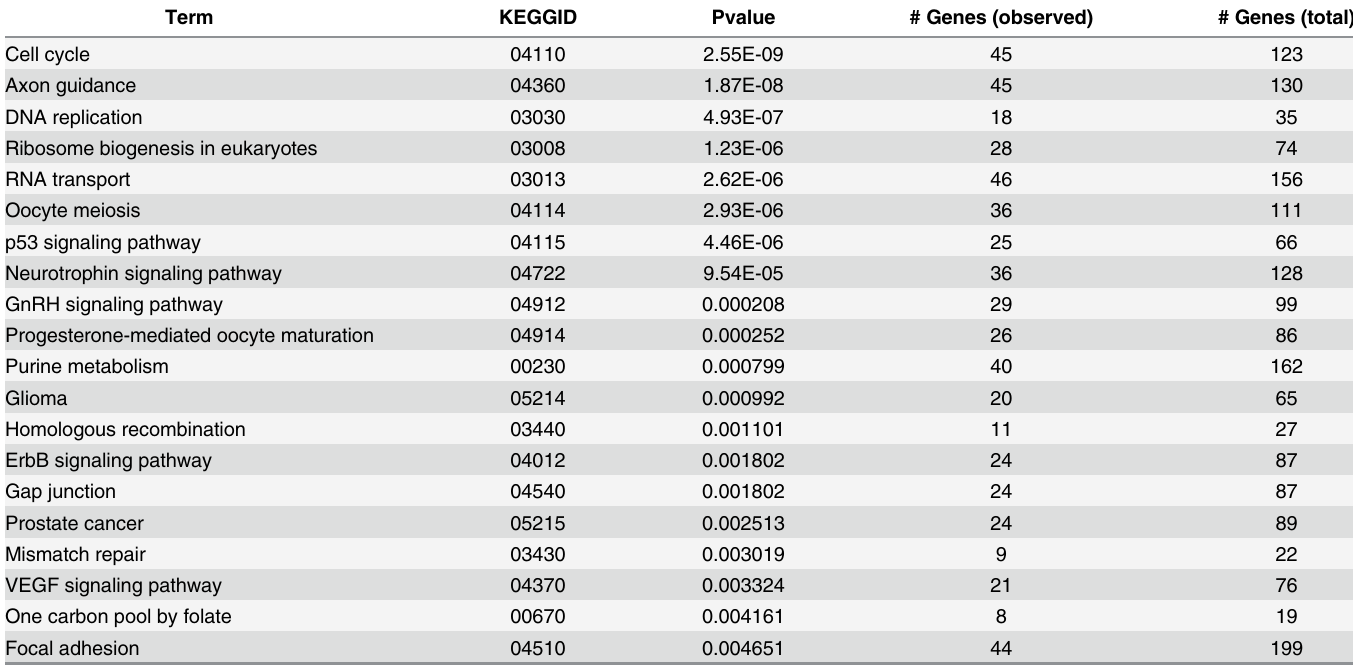
Table 1. Target enrichment in distinct KEGG pathways.